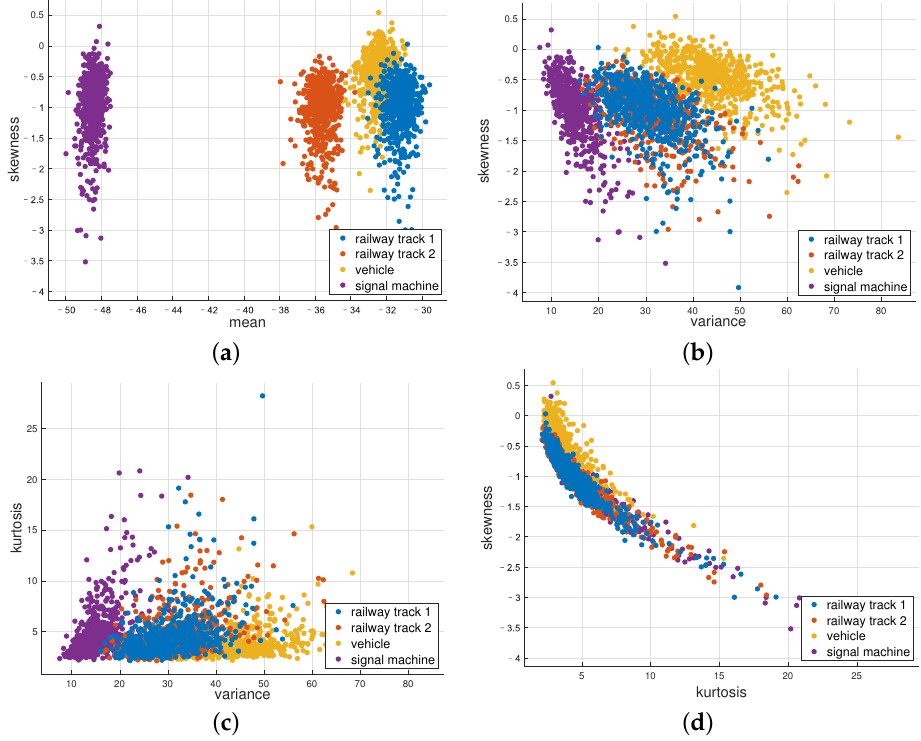
Figure 3. Overlapping areas between two statistical features. ( a ) x- mean y- skewness, ( b ) x- variance y- skewness, ( c ) x- variance y- kurtosis, ( d ) x- kurtosis y-